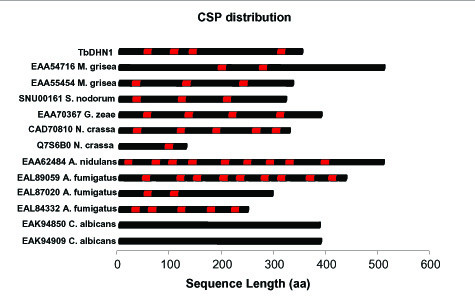
Distribution of the conserved signature pattern (CSP) within TbDHN1 and its homolog sequences. CSP is indicated with red boxes.